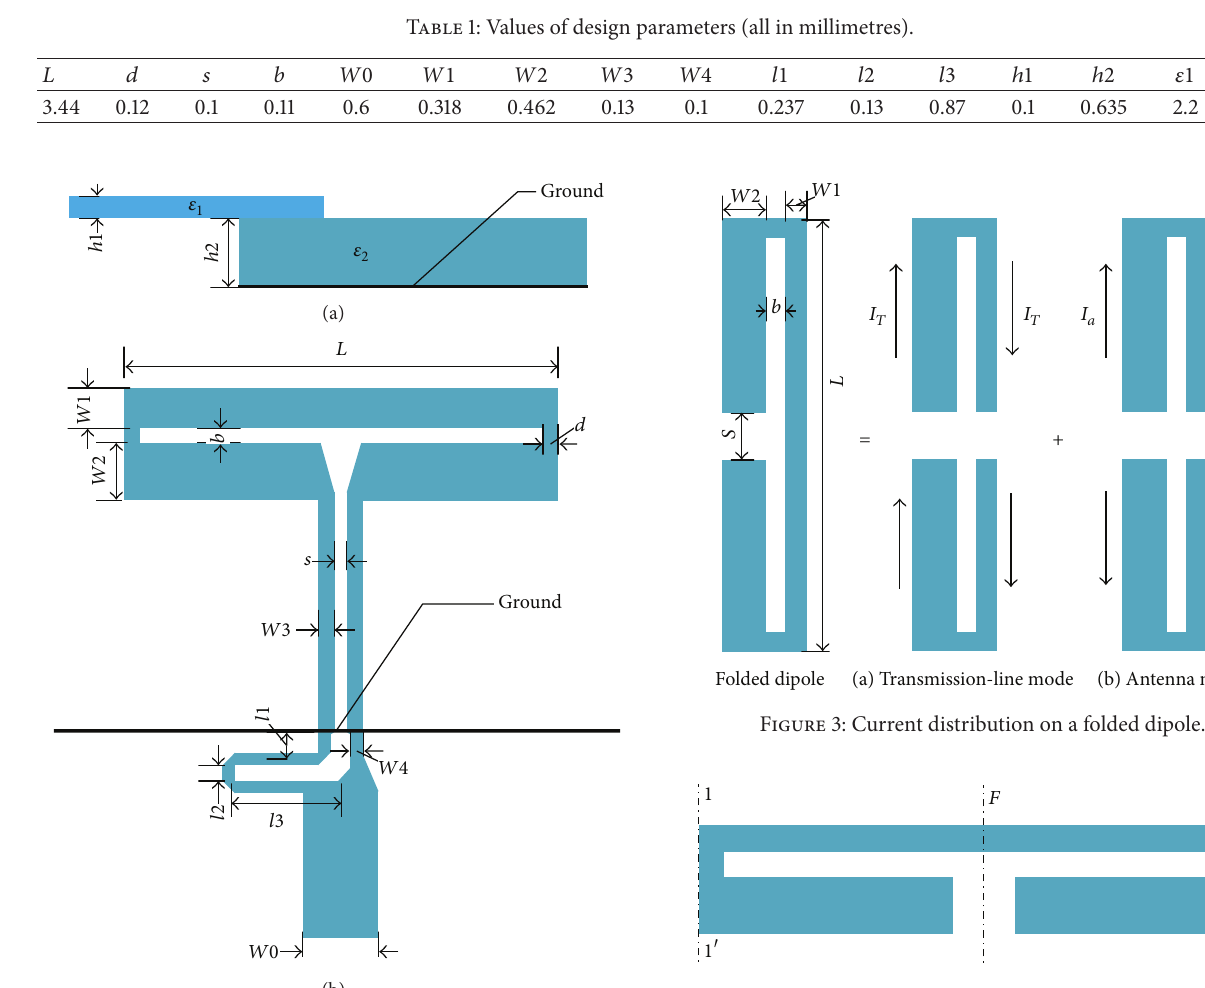
Figure 4: A strip asymmetric folded dipole in antenna